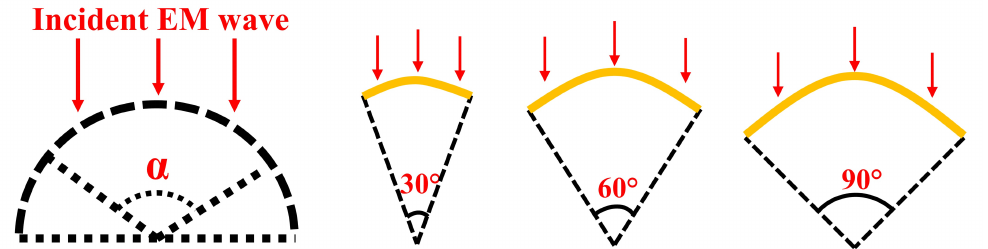
Figure 15. Illustration of incident EM wave on cylindrical surfaces with different radii.